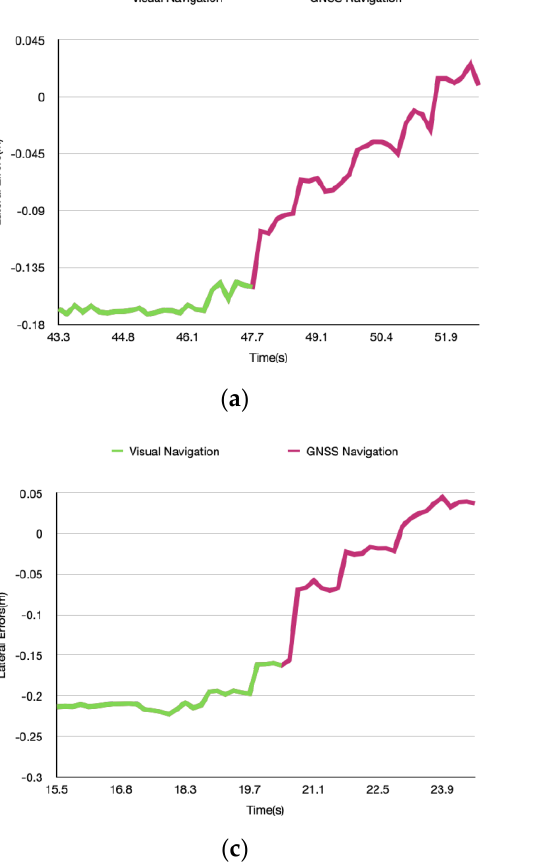
Figure 9. Some lateral error trajectories during the test. ( a ) Test 1; ( b ) Test 2 ; ( c ) Test 3; ( d ) Test 4 .